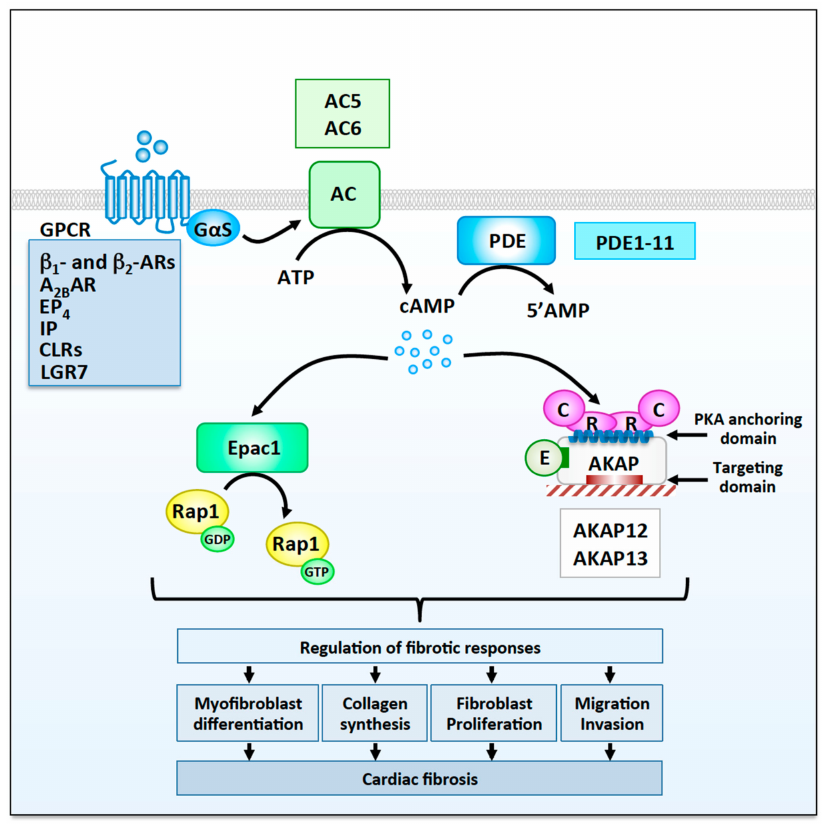
Figure 1. Cyclic adenosine monophosphate (cAMP) signaling modulators involved in the regulation fibrotic responses in cardiac fibroblasts. Cardiac fibroblasts express several Gs-coupled G protein-coupled receptors (GPCRs) including β 1 - and β 2 - adrenergic receptors (ARs), A 2B adenosine receptors (A 2B Rs), prostaglandin E 2 receptor 4 (EP4), prostacyclin receptors (IP), calcitonin receptor-like receptors (CLRs), and relaxin receptors (LGR7), which activate cAMP signaling cascades involved in the regulation of fibrotic responses. Stimulation of di ff erent membrane GPCRs is believed to induce the activation of distinct pool of ACs and the generation of separate cAMP microdomains. Phosphodiesterases (PDEs), which promote degradation of cAMP to AMP, are also involved in shaping intracellular cAMP microdomains. Two adenylyl cyclases, AC5 and AC6, as well as well as